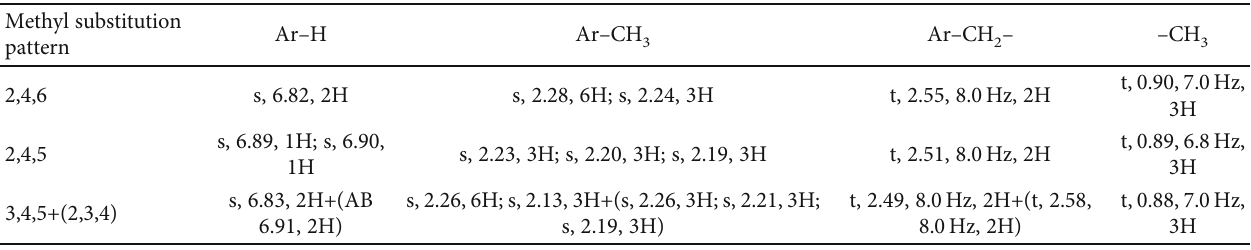
Figure 4: m/z 133+134 mass chromatograms of the four synthesized isomers of (a – c) trimethyl- n -hexylbenzene and the (d, e) C AAs (un fi lled triangles) in the aromatic fraction of oil sample (LN14O in Figure 1) before and after the coinjection of synthesized compounds. Filled cycles denote C AIP. 15 Table 1: 1 H-NMR data for trimethyl- n -hexylbenzenes. Shifts are the δ values in deuterated chloroform. The spectrums can be found in the supplementary